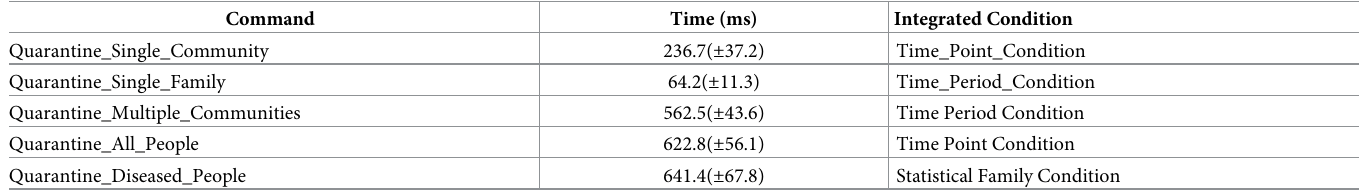
Table 7. Performance measure of commands. Runtime for commands is averaged over 100 command executions, showing the insignificance of commands runtime com- pared to other components of the simulator. Command